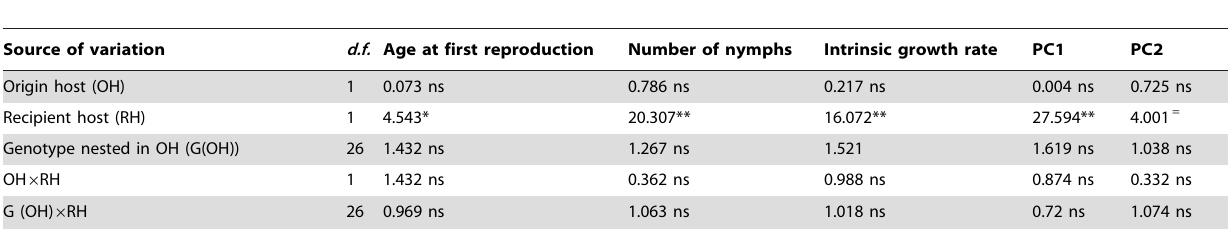
Table 2. Statistic F from analysis of variance of morphological (PC1, PC2) and life history traits of Brevicoryne brassicae reared on hosts Brassica campestris and Brassica oleracea .